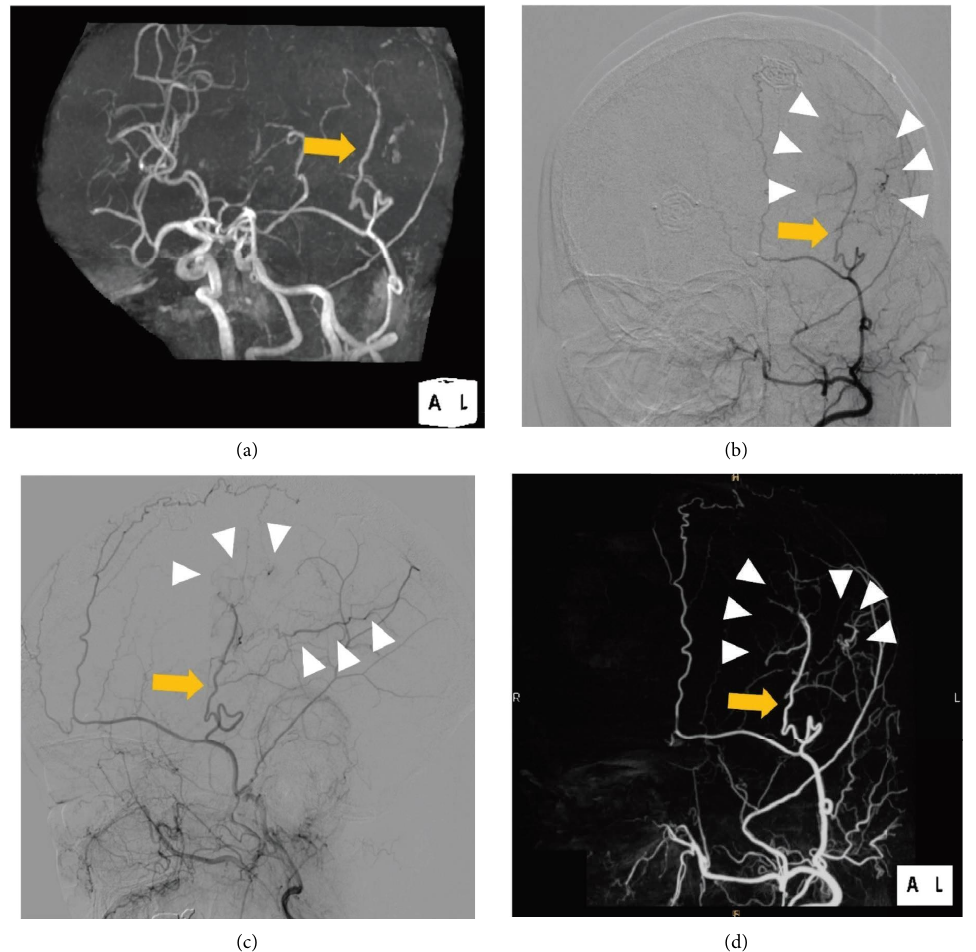
Figure 4: Radiological fndings after the second surgery. (a) Repeat magnetic resonance angiography showing the patent vessel of encephalo-arterio-synangiosis (arrow). Te patent superfcial temporal artery (STA) (arrow) and revascularized M4 segment of the middle cerebral artery (MCA) (arrow heads) were confrmed by digital subtraction angiography (DSA) of the external carotid artery (ECA); (b) left anterior-oblique and (c) lateral view. Tree-dimensional DSA of the ECA verifed good patency of the parietal branch of the STA (arrow) and the collateralized MCA (arrow heads); (d) left anterior-oblique